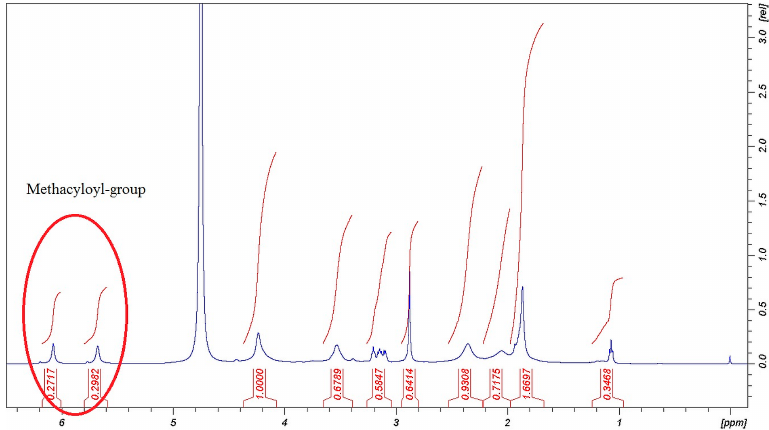
Figure 1. H 1 -NMR spectra of MPGA polymer.